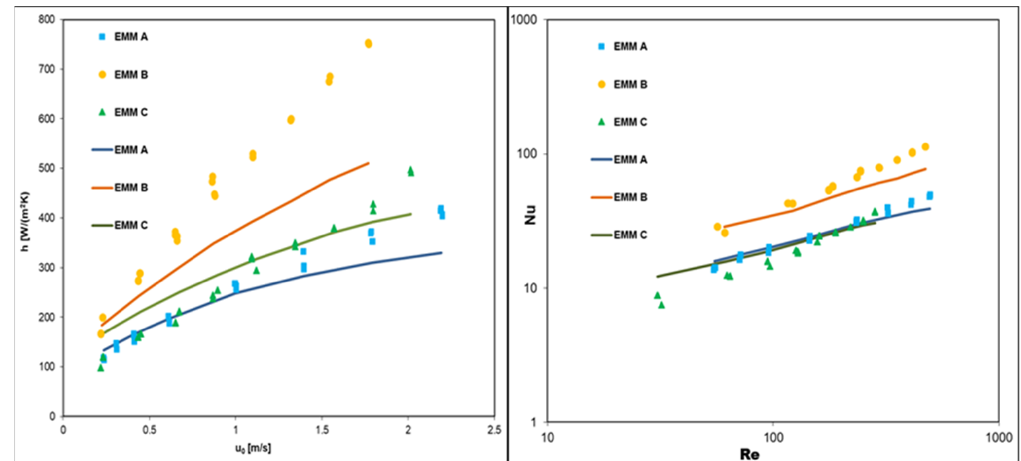
Figure 7. Heat transfer characteristics derived from experiments (points) and modeling (lines): left—heat transfer coefficient vs. superficial gas velocity; right—Nusselt number vs. Reynolds number.